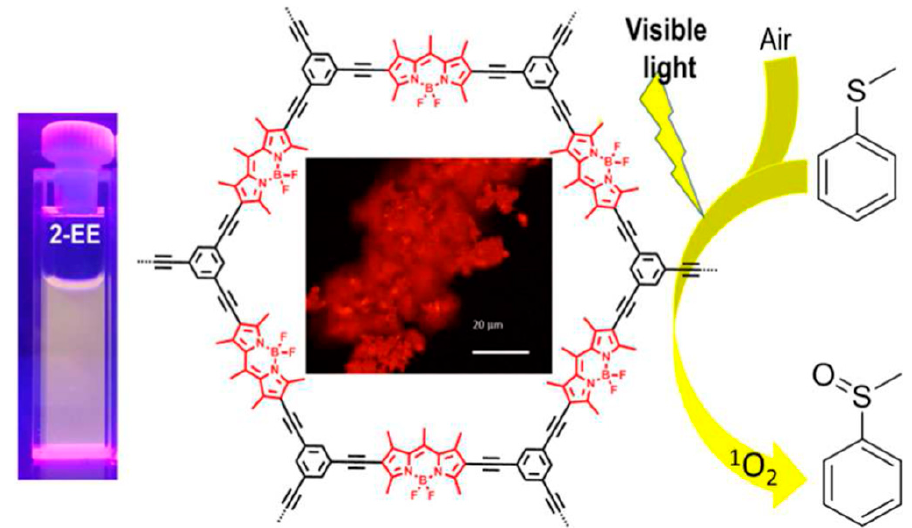
Figure 6. A structural illustration of CMPBDP with its fluorescence and catalytic performance. Reprinted with permission from [92]. Copyright 2016, American Chemical